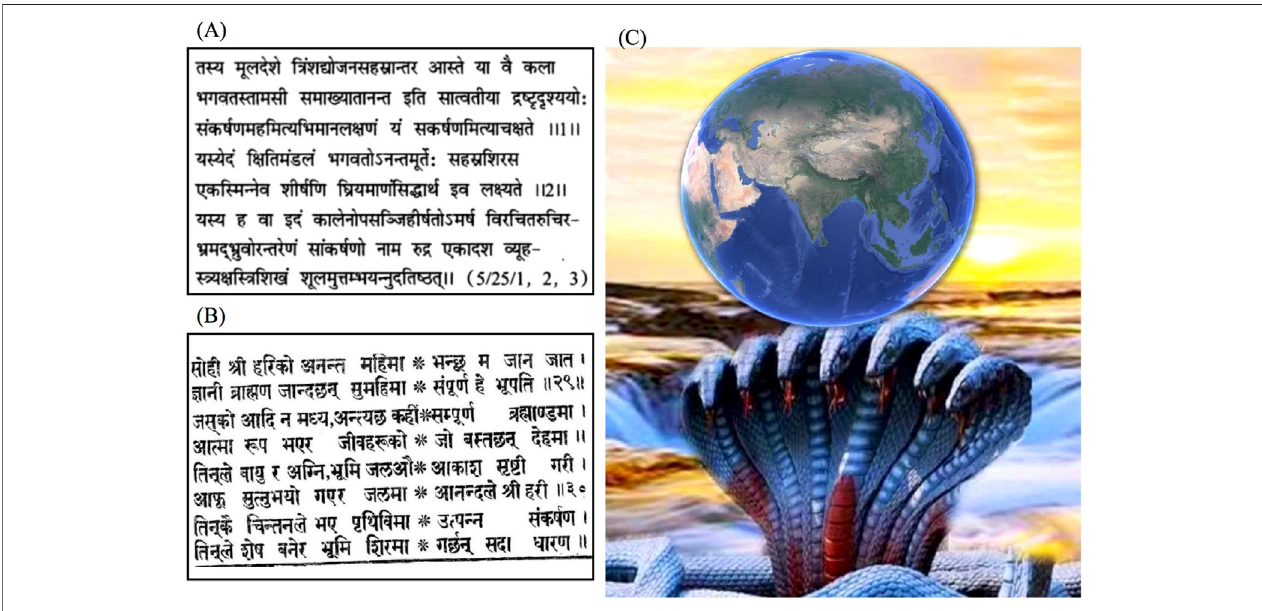
FIGURE 5 | The Earth is held by a Sheshnaag. (A) Explanation found in Purana in Sanskrit (Dwivedi, 2001). (B) Explanation found in Mahabharata in Nepali (Vyasa, 1883). (C) Schematic drawing of a seven-headed Sheshnaag supporting the Earth as explained in the text written in (A) and (B) (image modi fi ed after Sandeep, 2019).